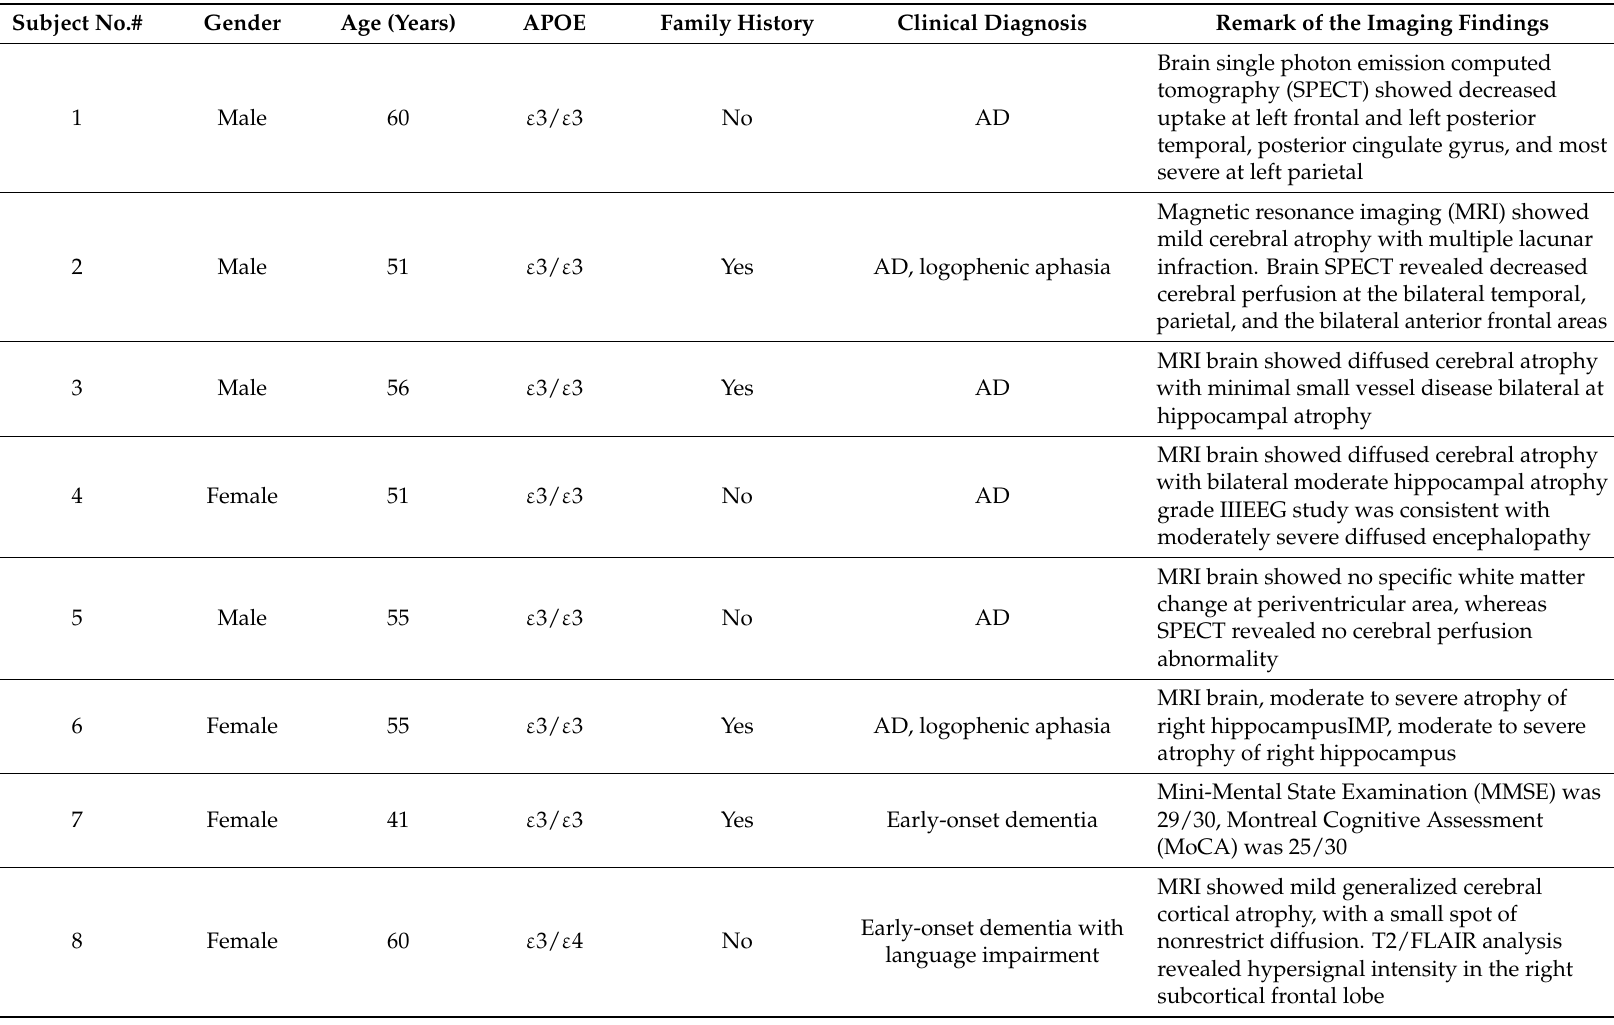
Table 1. Available demographic and clinical characteristics of 8 Thai patients with inherited early-onset Alzheimer’s disease